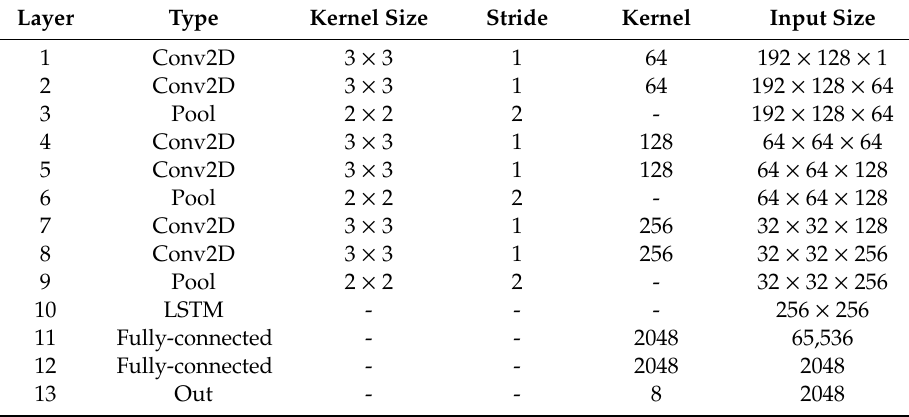
Figure 3. An illustration of the proposed CNN-LSTM architecture. Table 2. Detailed overview of the proposed CNN-LSTM model.